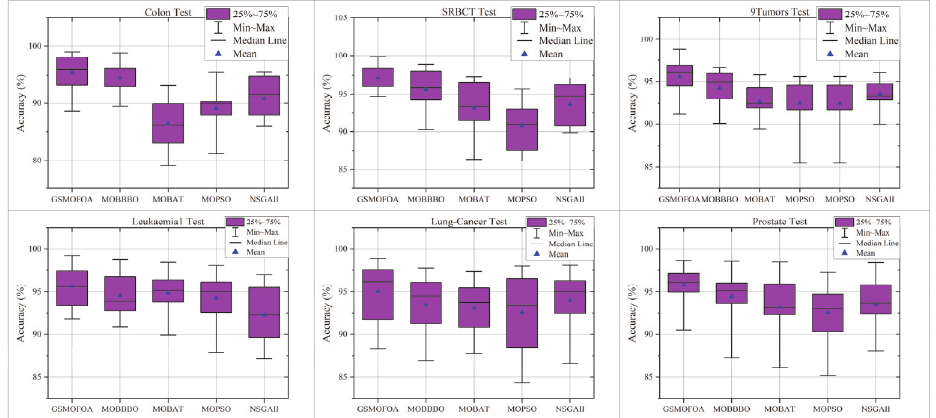
Fig. 6. Comparison between GSMOFOA solutions and other multi-objective algorithms on the test